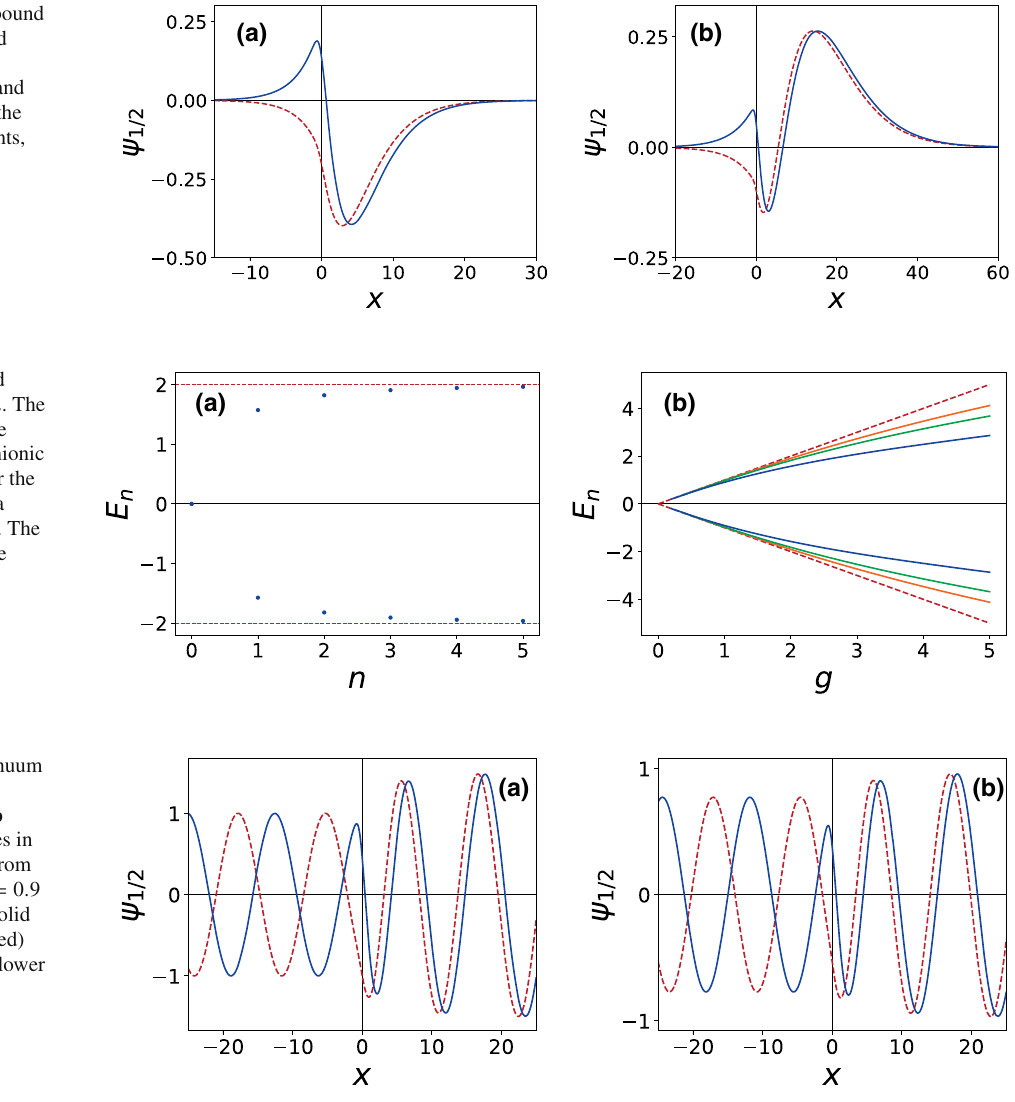
Fig. 7 a First fermionic bound state for g = 0 . 9. b Second fermionic bound state for g = 0 . 9. The solid (blue) and dashed (red) curves show the upper and lower components, ψ ψ 1 and 2 , respectively